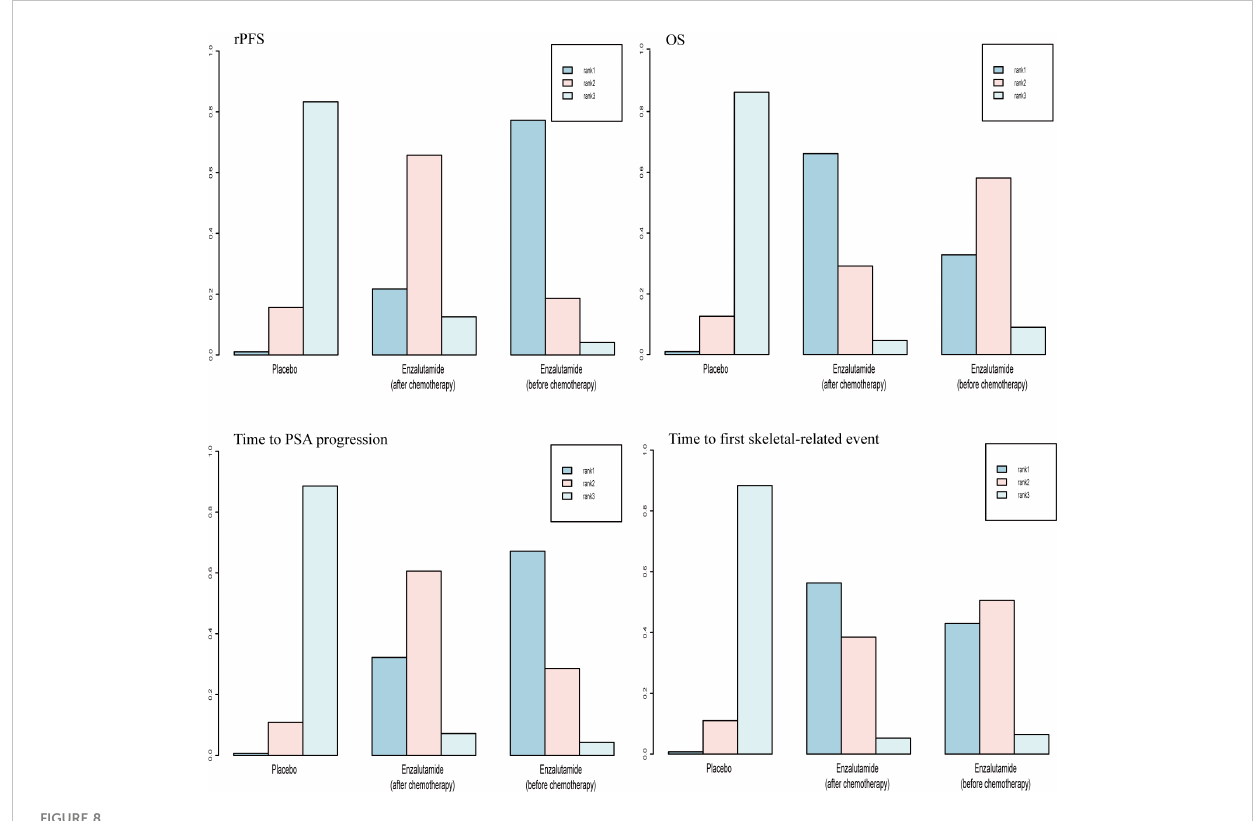
FIGURE 8 Rank probabilities of the SGARIs studied in the mCRPC